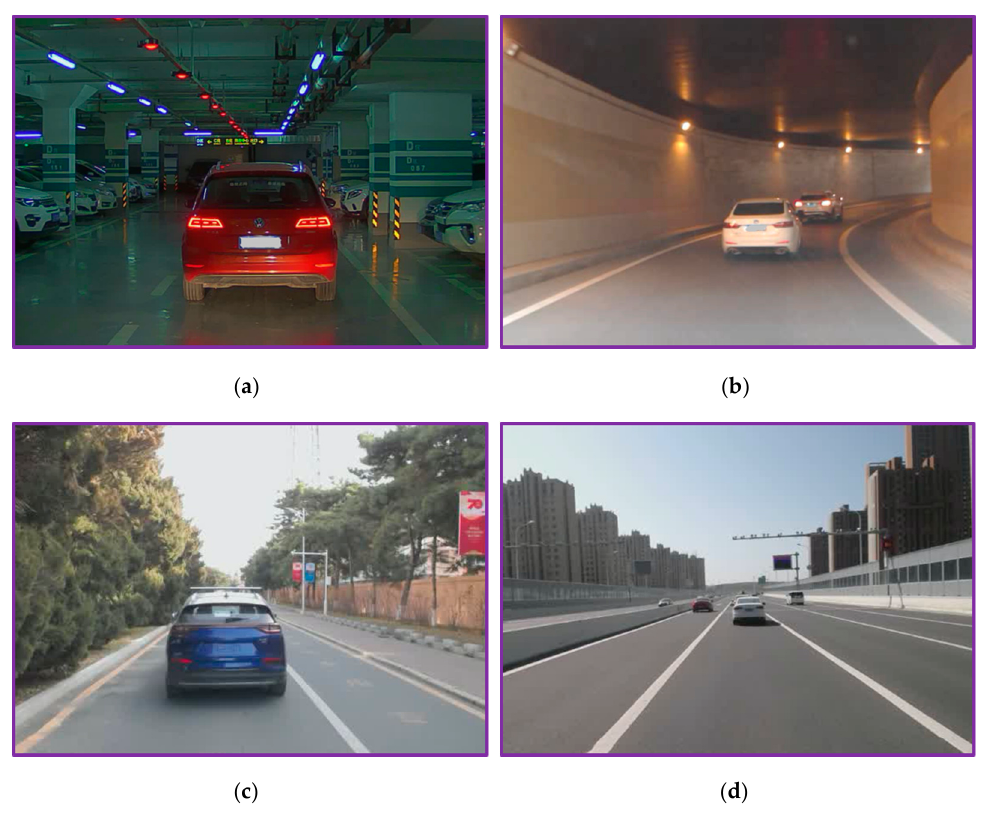
Figure 4. Experimental environment. ( a ) underground parking, ( b ) tunnel, ( c ) campus, ( d ) expressways.